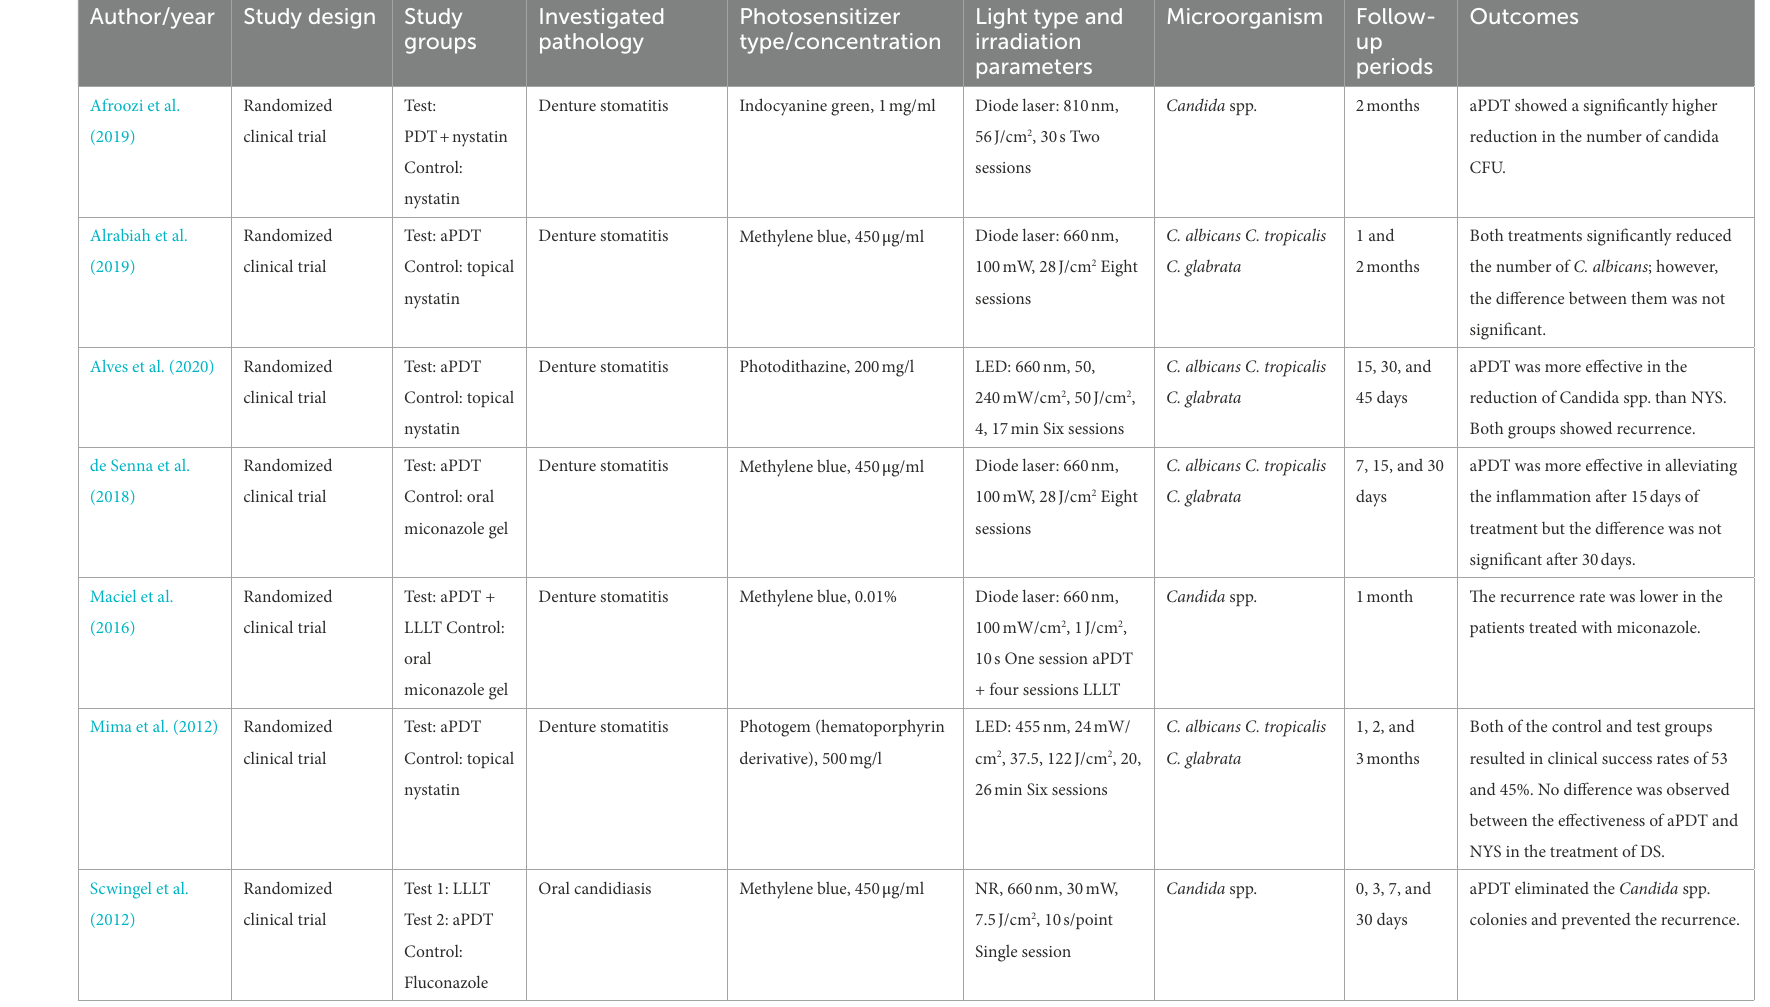
TABLE 5 aPDT treatment in patients with fungal